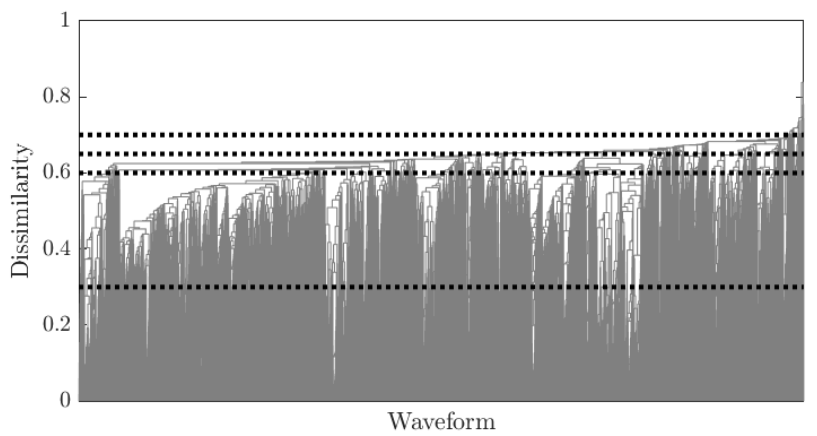
Figure 14. Dendrogram linking the data from the similarity matrix in Figure 13. The dashed lines represent the thresholds considered in the definition of clusters. Note that along the horizontal axis the waveforms are no longer ordered sequentially.